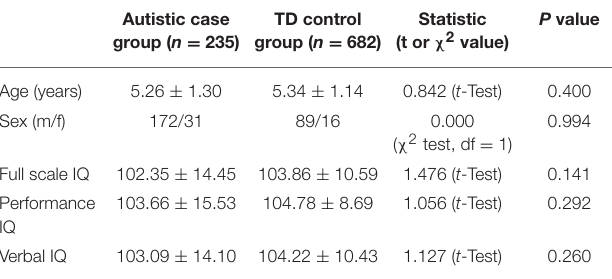
TABLE 4 | Participant characteristics in ASD case-control study (Mean ± SD ). TABLE 5 | The potential impact factors for ASD in population-based case-control